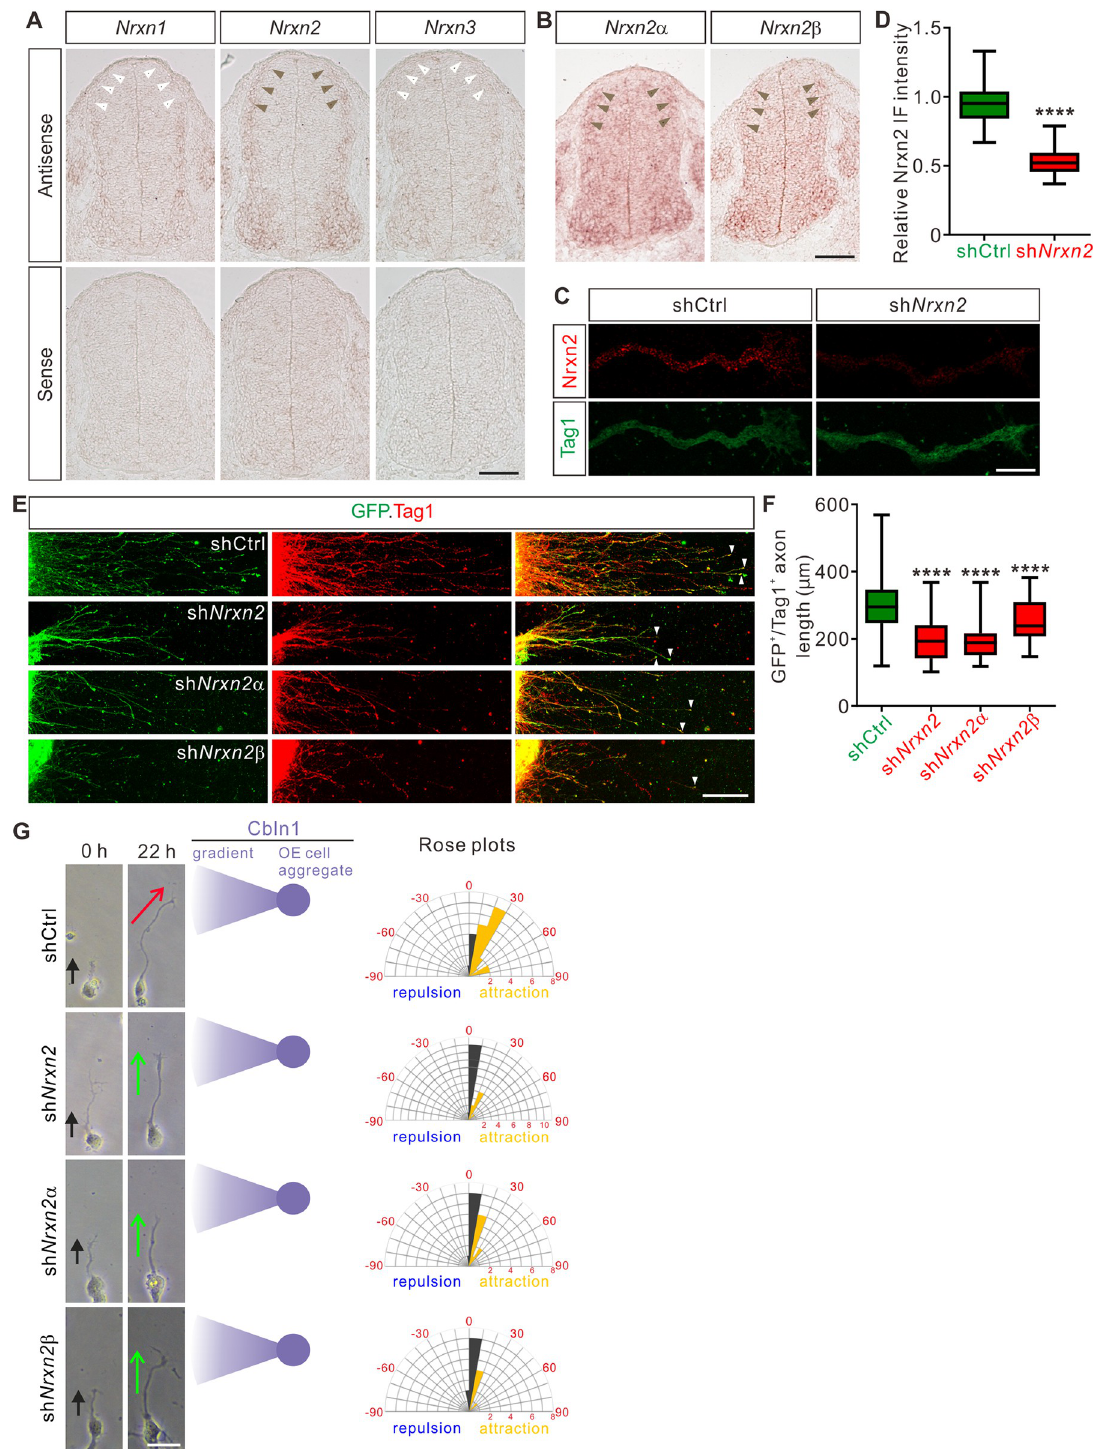
Fig 5. Nrxn2 mediates Cbln1-induced commissural axon growth and guidance as its receptor. ( A and B ) Nrxn2 , Nrxn2 α , and Nrxn2 β mRNAs were detected in E11.5 spinal cord cross-sections by in situ hybridization. Brown and white arrowheads indicate the expression ( Nrxn2 in A, Nrxn2 α and Nrxn2 β in B) or absence ( Nrxn1 and Nrxn3 in A) of the corresponding mRNAs in DCNs, respectively. Scale bars, 100 μ m (A, B). ( C ) Robust Nrxn2 IF signals were detected in the commissural axons and growth cones. Dissociated DCN neurons from E11 mouse embryos were cultured in vitro and Nrxn2 IF signals were imaged after lentiviral shRNA